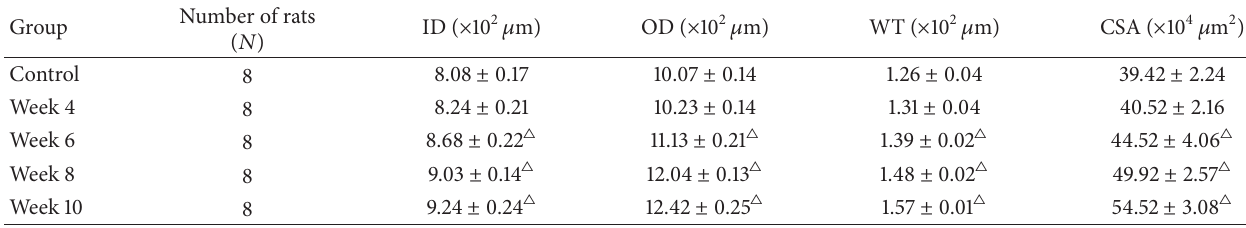
Table 2: Geometric changes in the portal vein ( 𝜒 ±